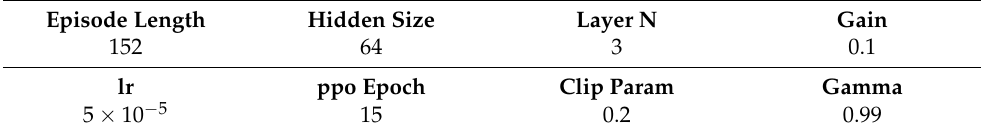
Table A1. MAPPO-RHC/PPO parameter setting.